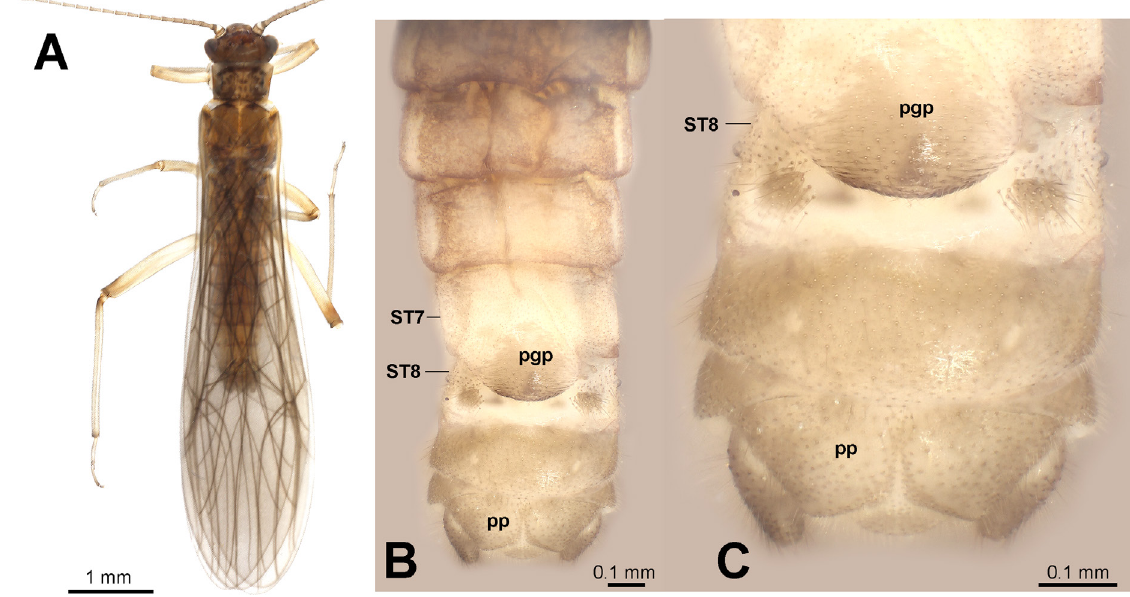
Fig. 5. Nemoura lixiana sp. nov. A . Female habitus, dorsal view. B . Female abdomen, ventral view. C . Female terminalia, ventral